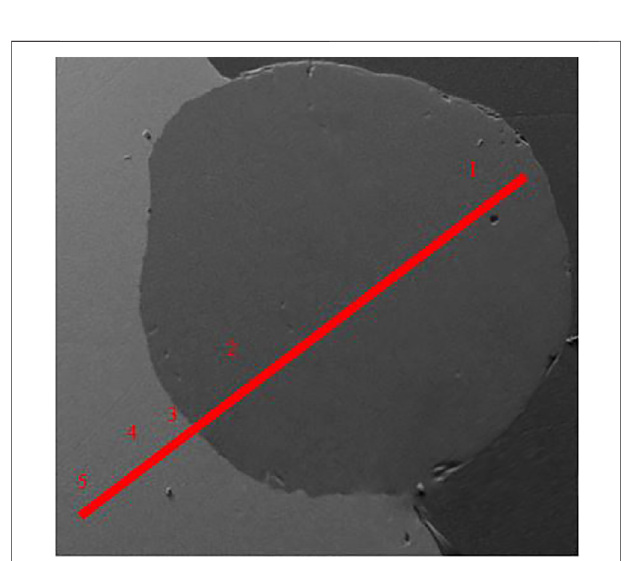
FIGURE 9 | SEM image of the 5 s sample at 1873 K with the point analysis showing the composition of Al and Si.